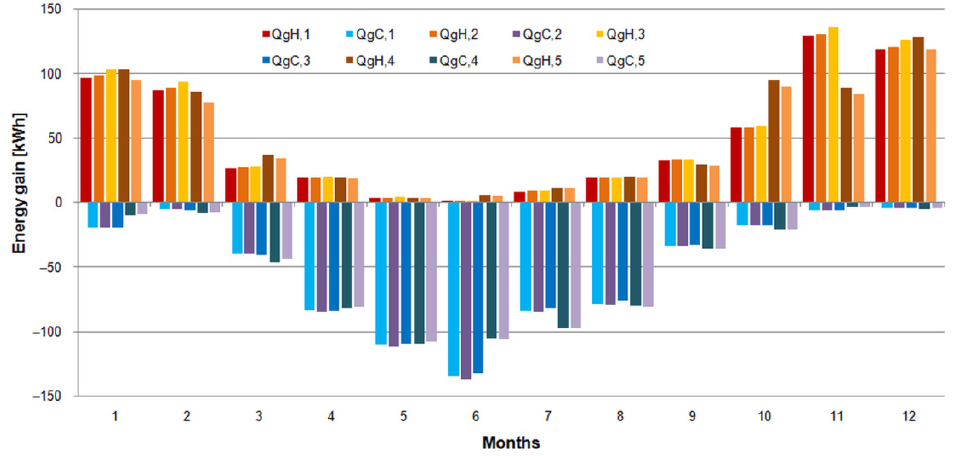
Figure 16. Monthly heating and cooling energy gain in EAHE from methods 1–5.